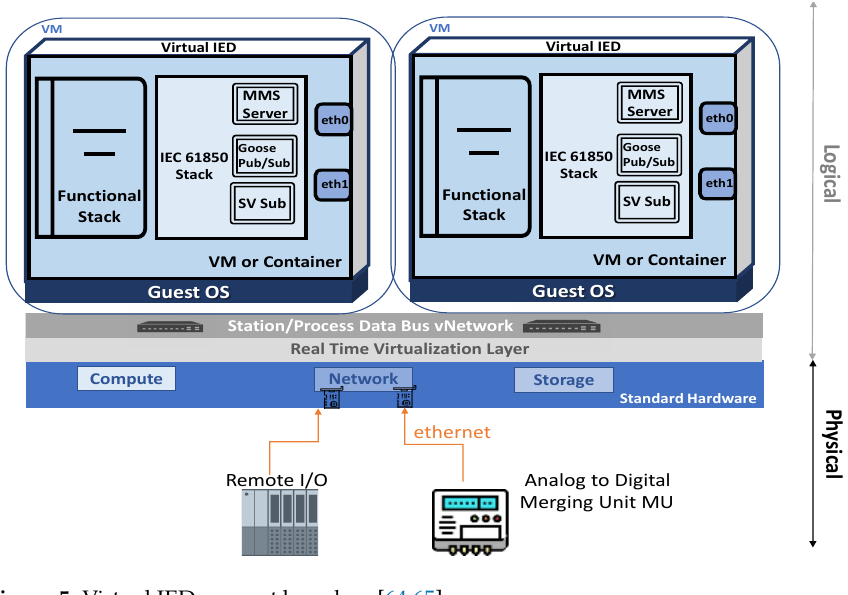
Figure 5. Virtual IED concept based on